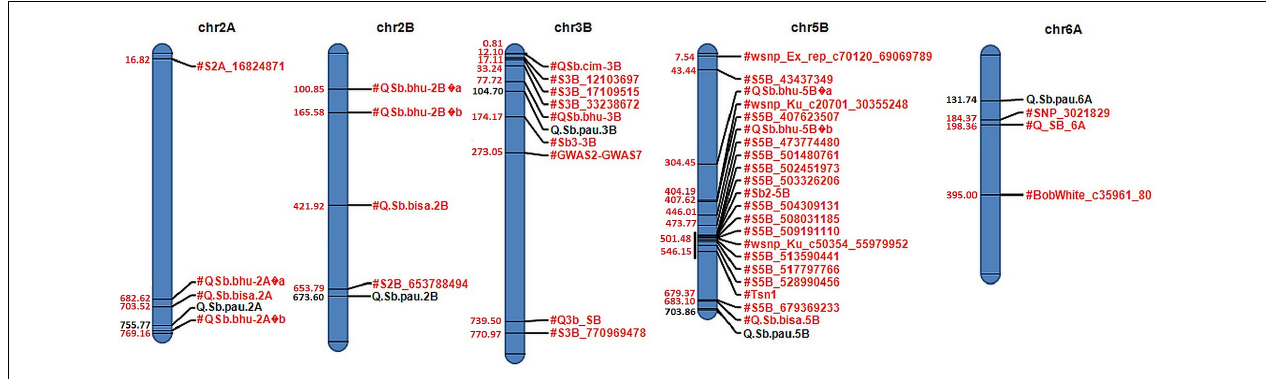
FIGURE 3 | Physical map of candidate QTLs on 2A, 2B, 3B, 5B, and 6A chromosomes. Significant QTLs mapped for resistance against spot blotch are highlighted in black with their respective physical positions (in Mb) in blue, while previously reported QTLs/markers are labeled in red.